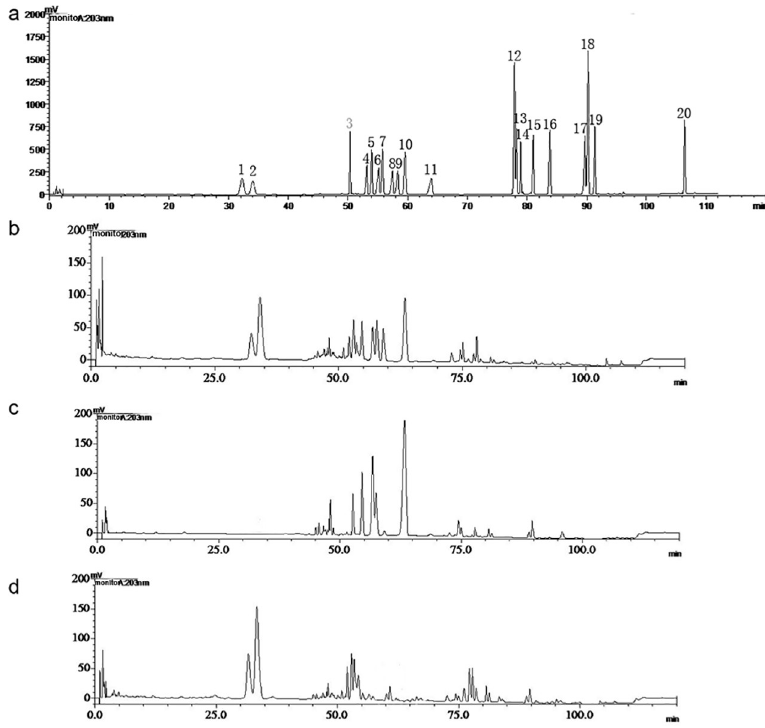
Fig 2. Composition of ginsenosides by HPLC. a, chromatogram of the 20 standard ginsenosides by HPLC analysis. Number 1–20 indicates composition of Rg1, Re, Rb1, Rg2, Rc, Rb2, Rb3, F1, Rd, F2, Rh4, Rg3, protopanaxatriol (PPT), compound K (CK), Rh1, Rf, and protopanaxadiol (PPD), respectively. Chromatogram of total ginsenosides from stem and leaf of Panax ginseng (b, GSLS), panaxadiols saponins (c, PDS) and panaxatriol saponins (d, PTS).